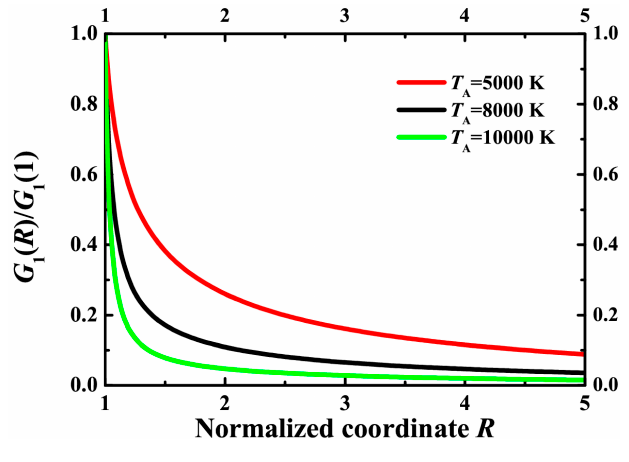
Figure 9. Normalized number of reacted molecules G 1 ( R )/ G 1 ( R = 1) according to Equation (21) for ΔT p = 100 K, T r = 300 K, T A = 10,000 K (green line), T A = 8000 K (black line) and T A = 5000 K (red